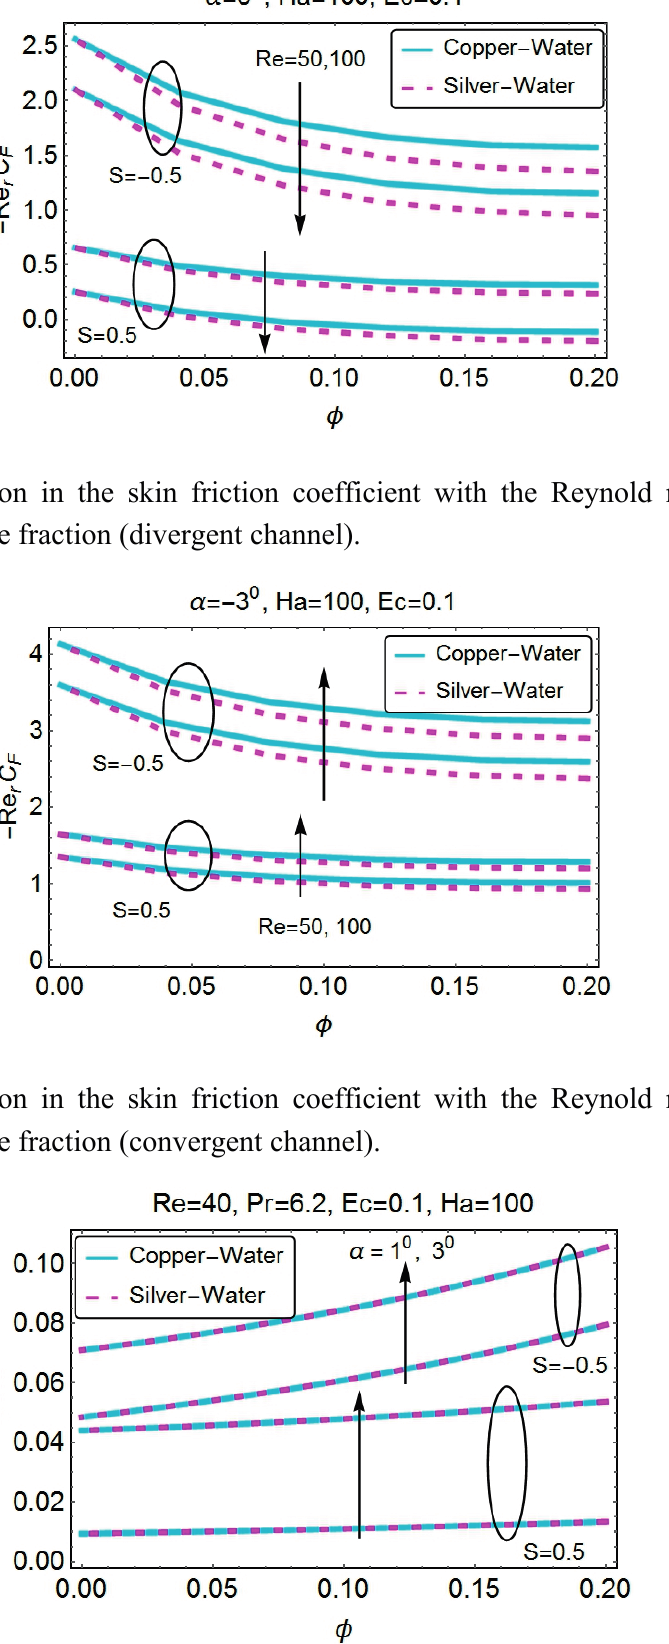
Figure 32. Variation in the Nusselt number with the angle and the nanoparticle volume fraction (divergent